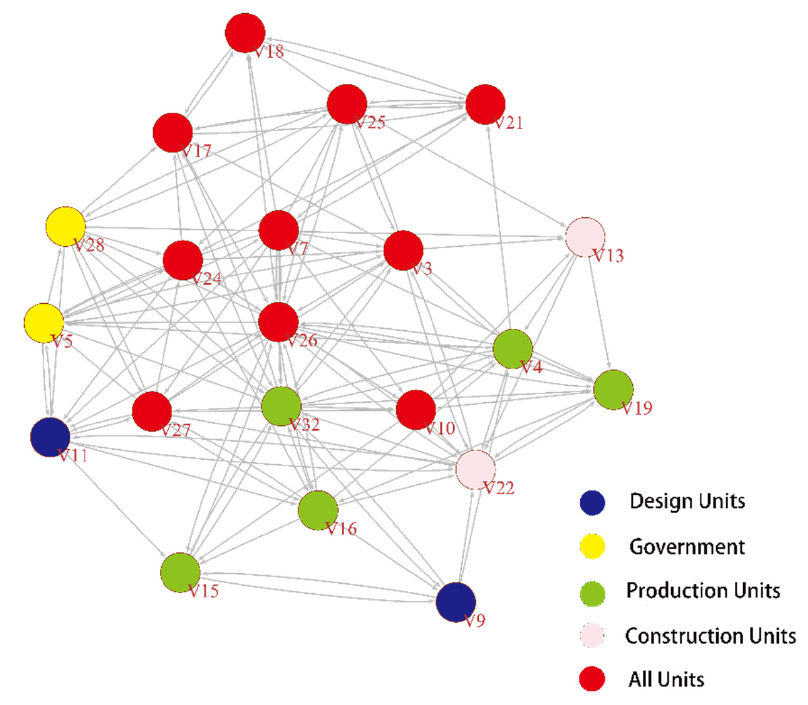
Figure 5. Complex network of risk association in Shandong Province.